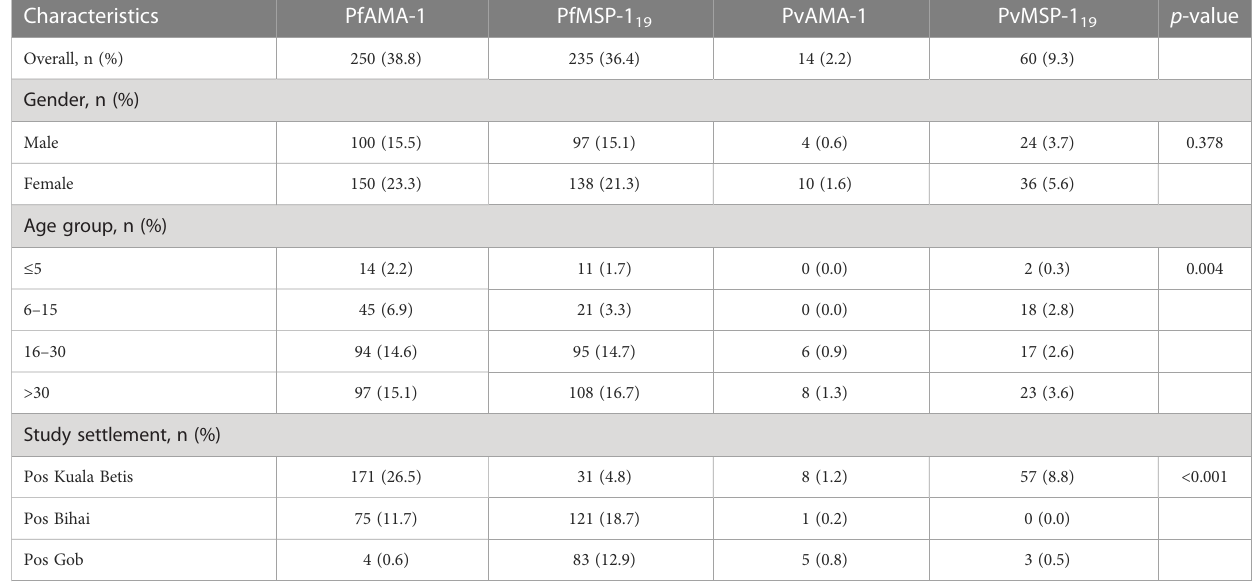
TABLE 2 Anti-malarial seropositivity for participants in three indigenous communities (N=645) in Gua Musang district, Kelantan state, Peninsular Malaysia.